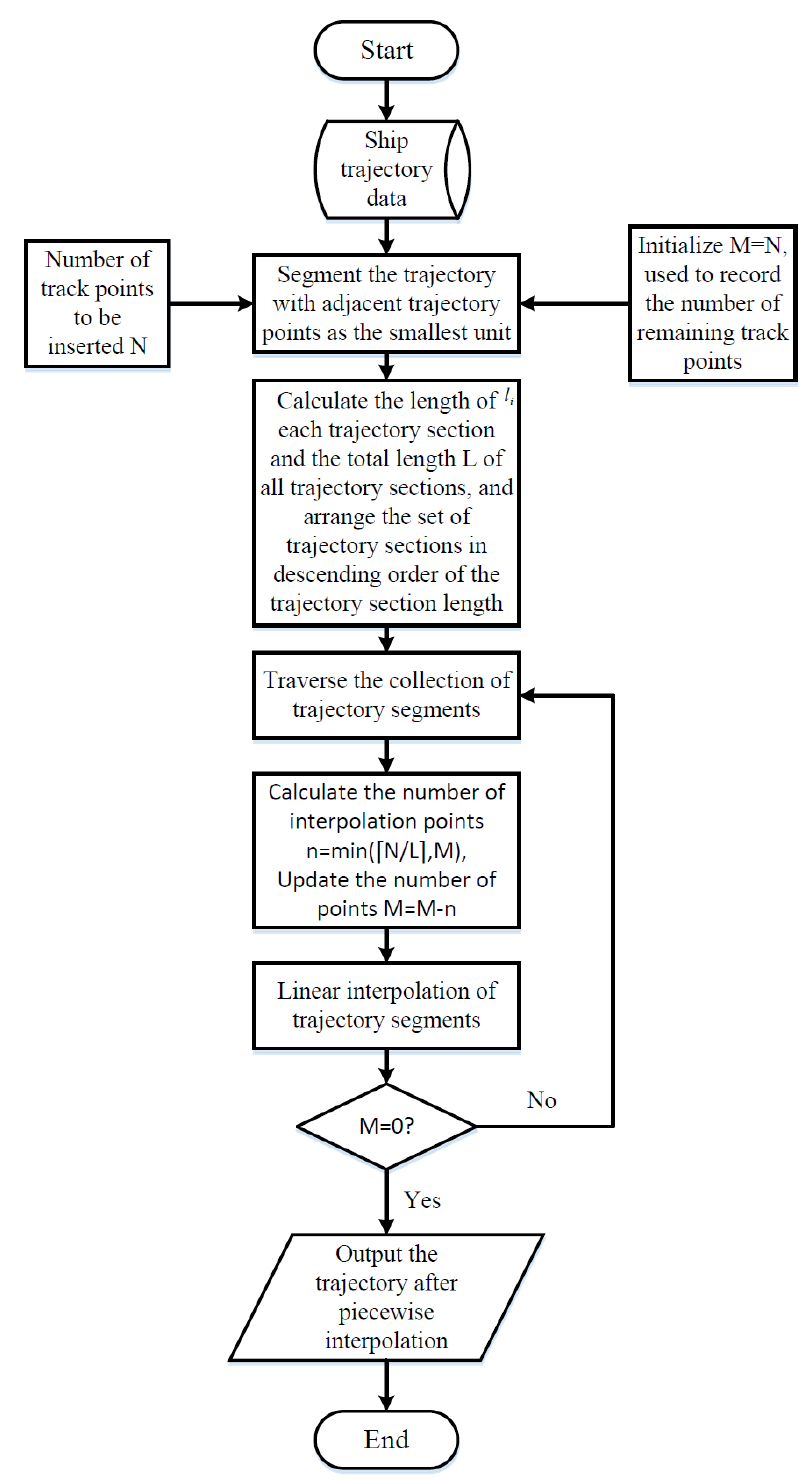
Figure 5. Low chart of segmented interpolation.